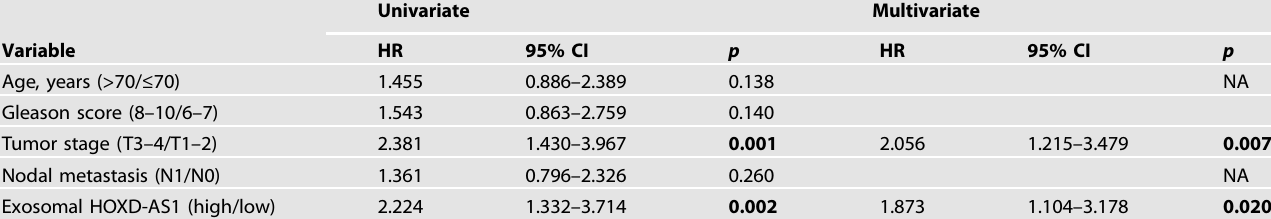
Exosomal HOXD-AS1 (high/low) Univariate and multivariate analysis. Cox proportional hazards regression model. Variables associated with survival by univariate analyses were adopted as covariates in multivariate analyses. Signi fi cant P -values are shown in bold font. HR >1, risk for death increased; HR <1, risk for death reduced. Median relative expression of serum exosomal HOXD-AS1 was used as cut-off value for